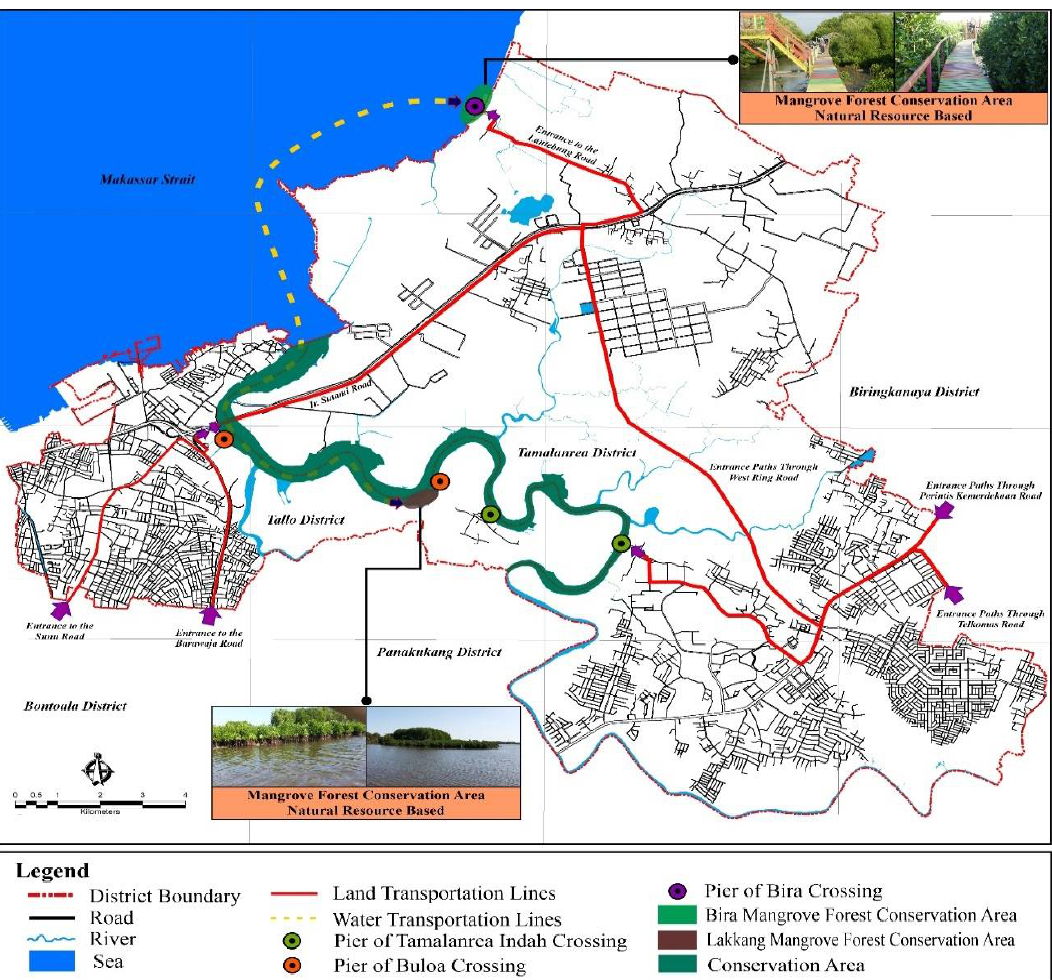
Figure 11. Integration of the Natural Resource Conservation System in the Tallo River Basin in Makassar City.